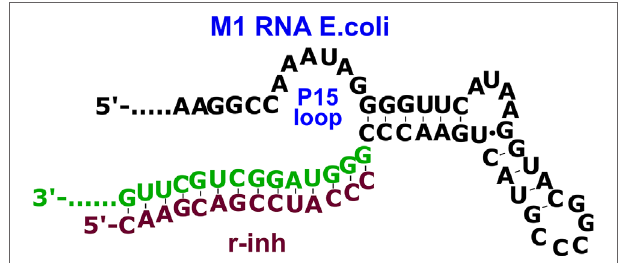
FIGURE 2 | The complex of oligoribonucleotide inhibitor ( r-inh ) with P15 loop region of the M1 RNA E. coli .